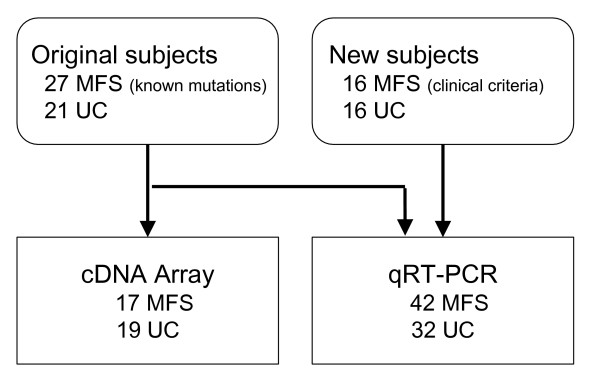
Overview of the experimental design. We used spotted membrane DNA arrays to characterize gene expression from MFS samples with known FBN1 mutations and from unaffected control samples. Following analysis of both groups, we selected a set of genes for validation by qRT-PCR, using a majority of the original samples. A new population of 16 probable MFS, all with an aortic phenotype, and 16 UC samples were used to test independently whether the selected genes were differentially expressed between the two groups. See Table 1 for details about subjects included in each experiment.